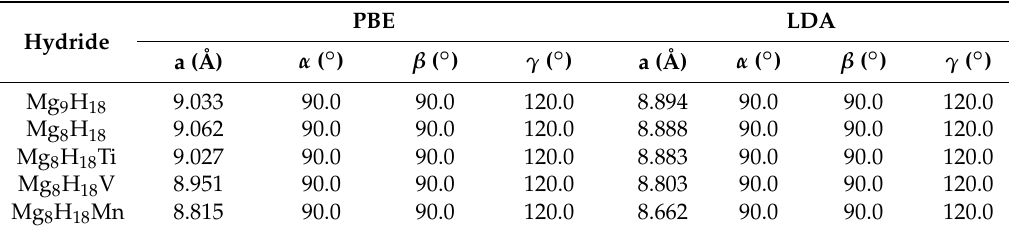
Table A1. The relaxed structure parameters of pure, vacancies, and doped Mg 9 H 18